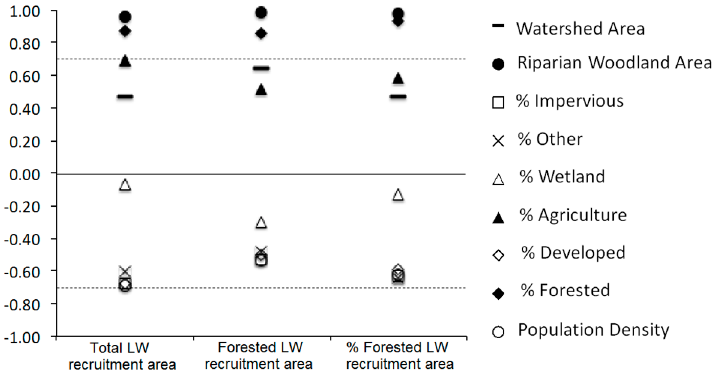
Figure 6. Correlation coefficient between large wood (LW) recruitment zone area, forested LW recruitment zone area, and percentage of LW recruitment zone area that is forested-from Table 3) and select land cover variables (from Table 1). Dashed lines indicate significant correlation levels (if r > 0.70 or r < − 0.70, then p < 0.05; n = 6).